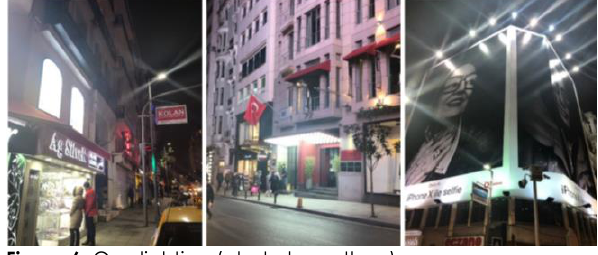
Figure 6. Overlighting (photo by authors)